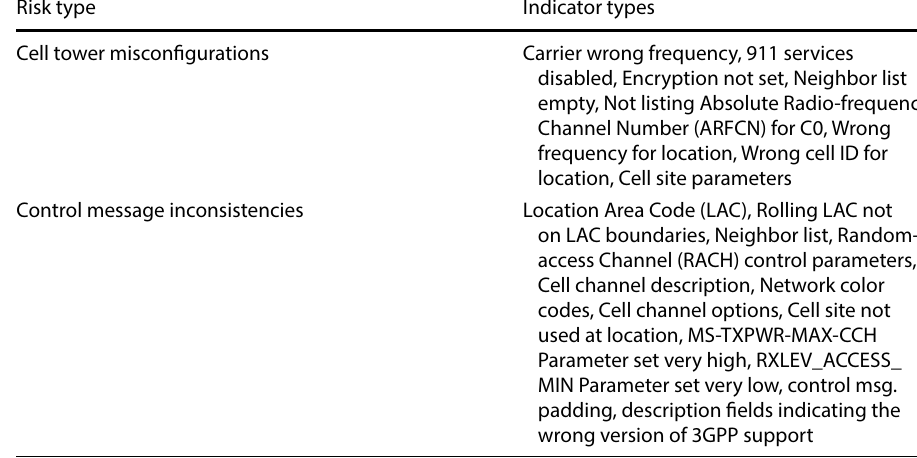
Table 2 Risk types and fake cell tower